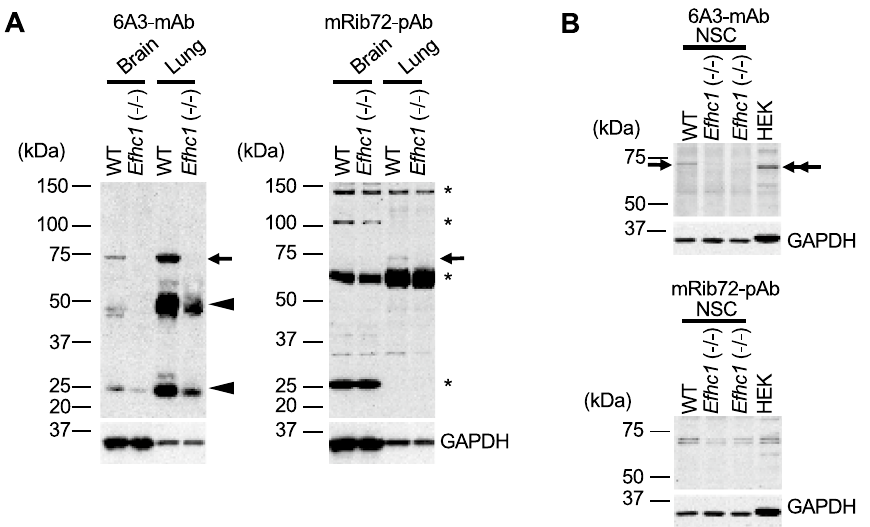
Figure 1. The 6A3-mAb specifically detects myoclonin1 at ~ 75 kDa, while mRib72-pAb detects multiple non-specific signals besides myoclonin1. ( A ) Western blots of brain and lung lysates probed with 6A3-mAb or mRib72-pAb (two independent experiments, N = 1 WT and 1 Efhc1 −/− ). Myoclonin1 was detected by both antibodies at the expected size (~ 75 kDa, arrows) in the lysates from WT, but not in those of Efhc1 −/− mouse. The 75 kDa band by mRib72-pAb was quite weaker than that of 6A3-mAb in the lung, and it was hardly detectable in the brain. The mRib72-pAb also detected additional bands (asterisks) that are much more intense than that of myoclonin1, and those remained in Efhc1 −/− mouse. Mouse IgG in mouse tissue lysates was detected by anti-mouse IgG secondary antibody (arrow heads in left panel). ( B ) Western blots of lysates from NSC and HEK cultured cells (two independent experiments, N = 1 WT and 2 Efhc1 −/− ). The 6A3-mAb detected 75 kDa band in cultured mouse neurosphere cells (NSC, arrow) from WT and HEK cells (double arrow), and this band well disappeared in Efhc1 −/− mouse. The molecular size of human myoclonin1 (640 amino acids, a.a.) in HEK cells is a little smaller than that of mouse myoclonin1 (648 a.a., GenBank accession number: ACB20692). In contrast, the mRib72-pAb detected multiple bands those remained in Efhc1 −/− mouse. An antibody to GAPDH was used as a control and shown in the lower panels ( A , B